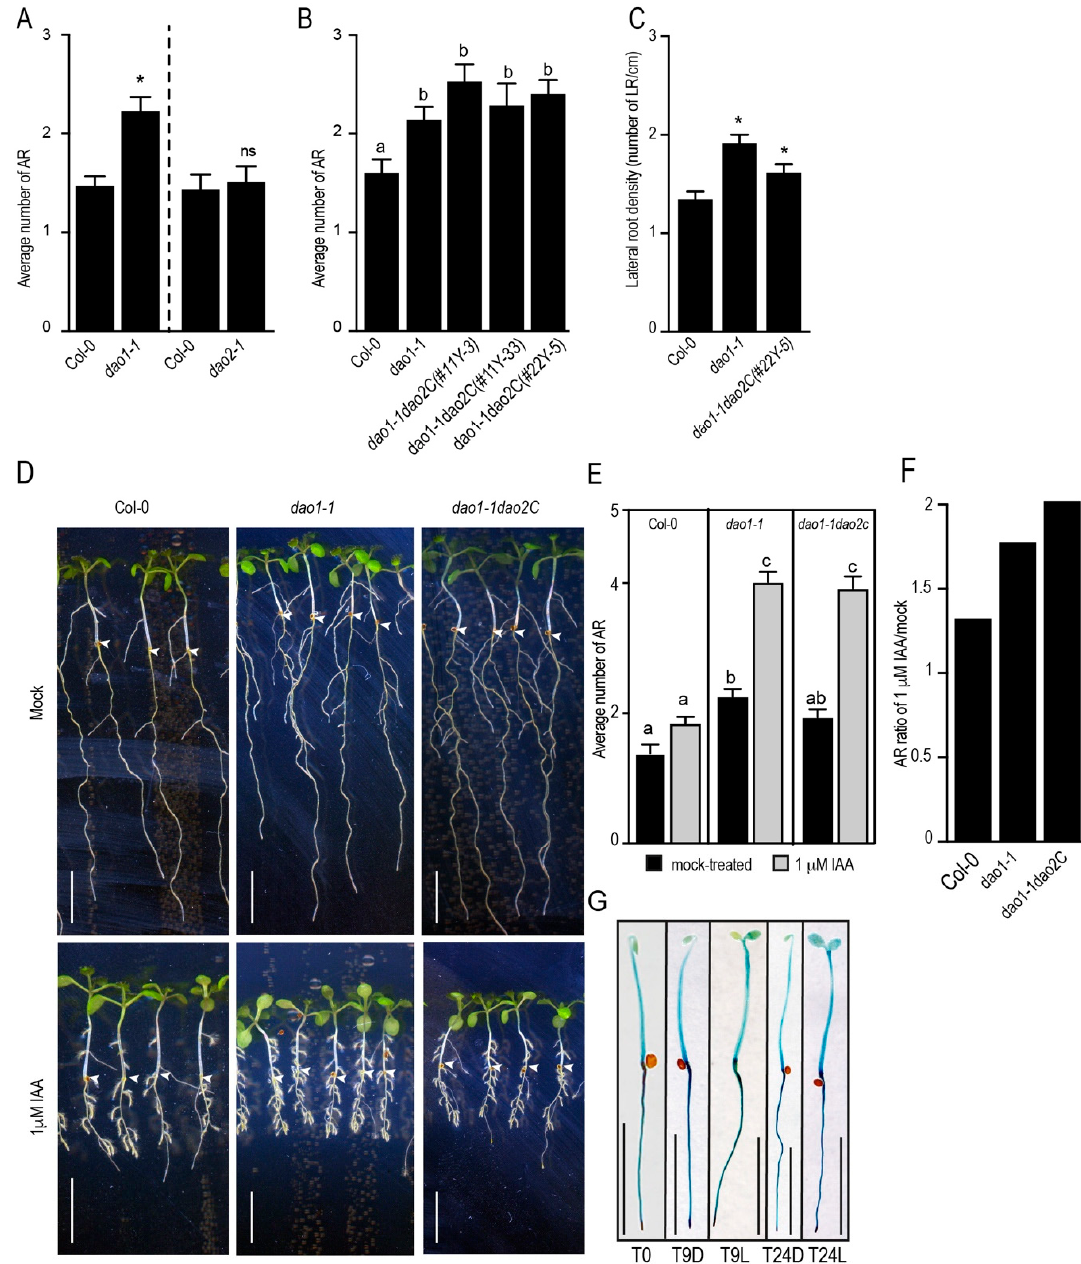
Figure 3. DAO1 , but not DAO2 , plays a major role in IAA oxidation during ARI. ( A , B ) Average number of ARs in dao mutants. Seedlings were grown in AR phenotyping conditions. ( A ) A t -test indicates that the dao1-1 mutant exhibits significantly more ARs than the wild type (inidicated by an asterisk). Error bars indicate ± SEM ( n > 30; p < 0.001). ( B ) One-way ANOVA combined with Tukey’s multiple comparison post-hoc test indicates that the dao1-1 single and dao1–1dao2C double mutants exhibit significantly more ARs compared to the wild type. The values indicated by di ff erent letters are significantly di ff erent from each others. Error bars indicate ± SEM ( n > 20; p < 0.001). ( C ) Density of lateral roots (LRs) (i.e., the number of LRs per cm of primary root) in dao mutants grown in AR phenotyping conditions. One-way ANOVA combined with Dunnett’s multiple comparison post-hoc test indicated that the LR density was significantly a ff ected in dao1-1 single and dao1–1dao2C double mutants (inidicated by an asterisk). Error bars indicate ± SEM ( n > 20; p < 0.001). ( D ) Wild-type and dao mutant seedlings were grown in the dark until their hypocotyls reached 6 mm long, when they were transferred to fresh medium containing either mock solution or 1 µ M IAA. The seedlings were kept for seven more days under long-day conditions to induce ARs. Arrow heads indicate